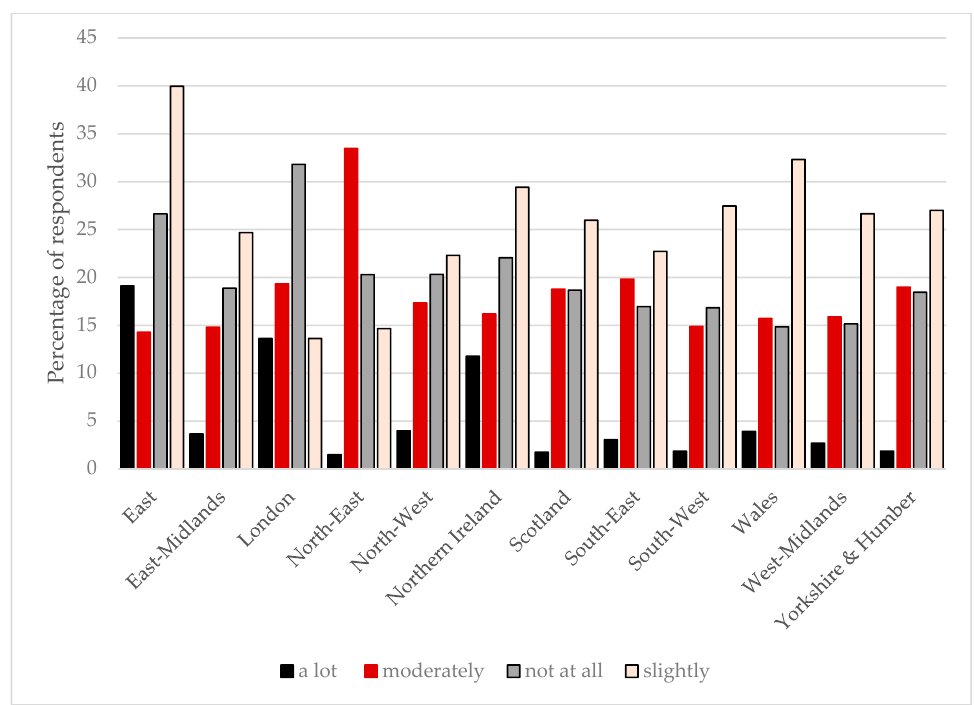
Figure 6. The impact of COVID-19 on horse owners by UK region. Respondents were asked to rank the impact of COVID-19 to date on the management of their horses and whether this had been affected a lot, moderately, slightly, or not at all. The data are reported by United Kingdom geographical region. Changes to equine management regimes were experienced across all regions, the majority of these had been self-imposed by the horse owner (London: 32%; North-East, Yorkshire and Humber and Northern Ireland range: 42–47%; and range in remaining regions: 52–60%; p = 0.0005). Significant reductions in how many times a day horse owners could visit their horse were found between the regions ( p = 0.0005); London and the North-East were the most affected, while the South West and Wales were the least affected (Figure 7).